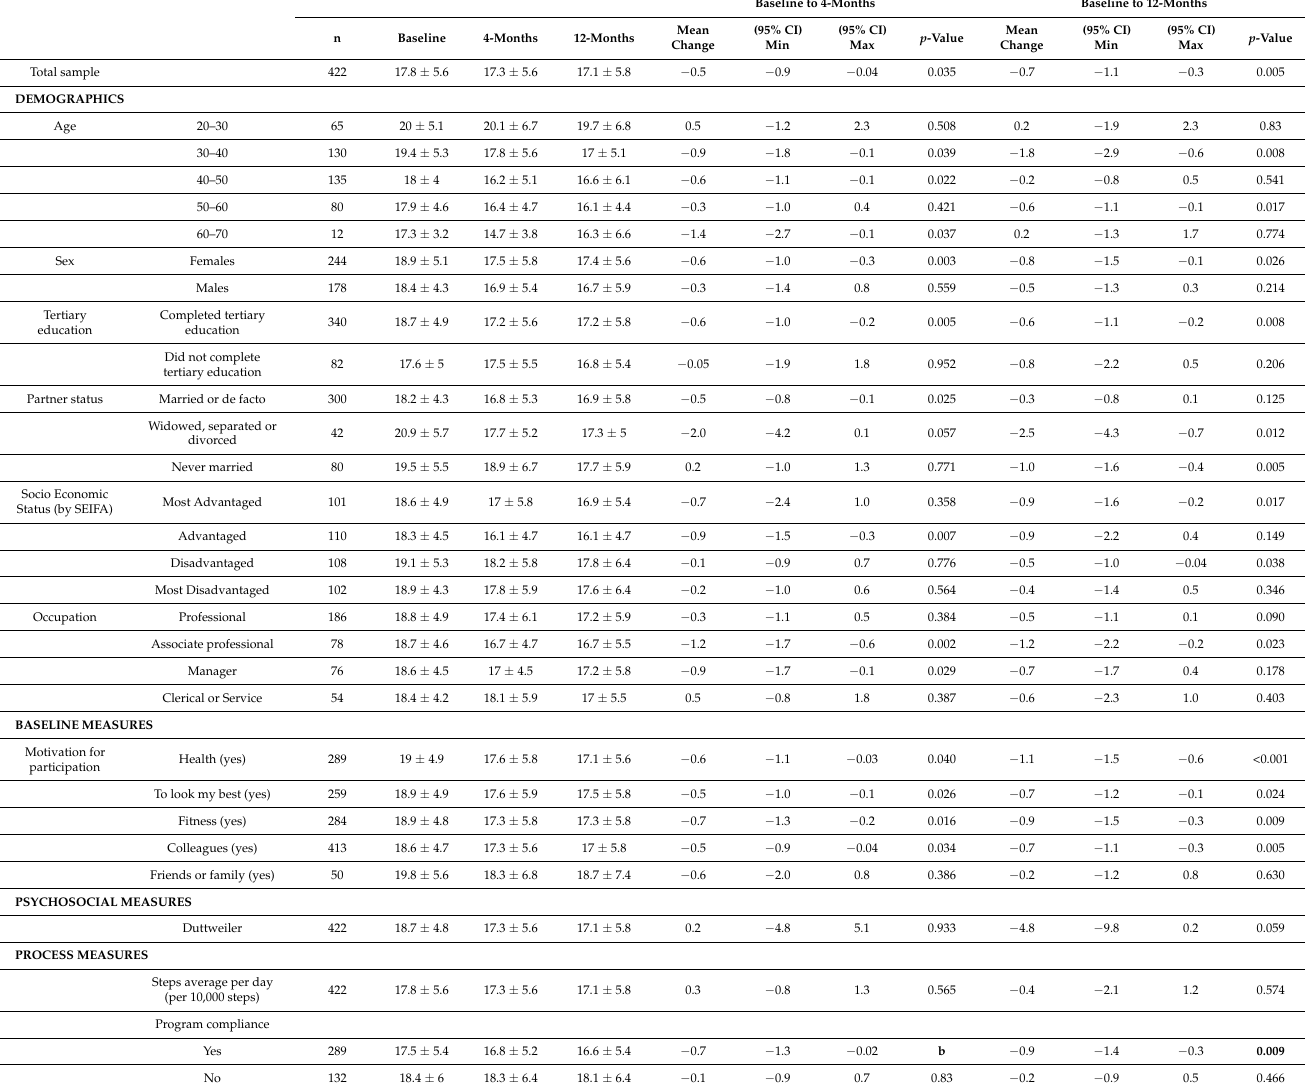
Table A4. Immediate and long-term change in psychological distress (K10 scores) associated with par- ticipation in a physical activity workplace program, stratified by demographic, baseline, psychosocial and process measures (measures taken at